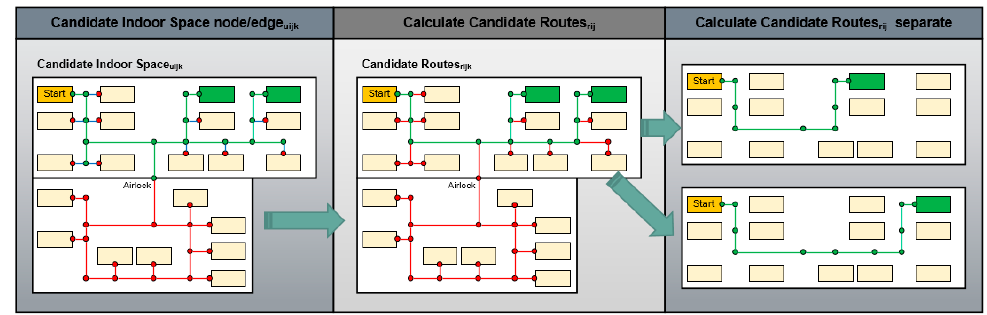
Figure 5. Intermediate results showing the limitation of the candidate indoor space node/edge uijk to all possible candidate routes rij .